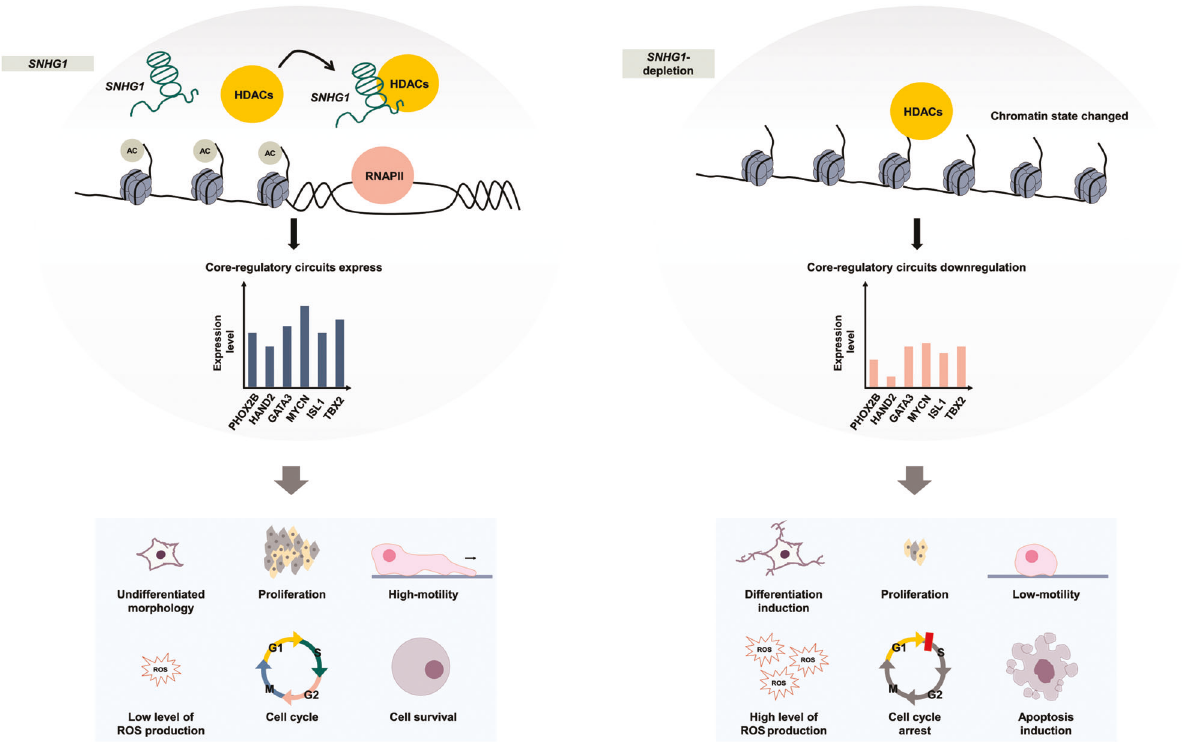
Fig. 6 Proposed mechanism of SNHG1 mediation in MYCN -ampli fi ed neuroblastoma cells. First, we examined how SNHG1 interacted with HDAC complexes, which regulate chromatin remodeling and cancer progression. Second, we validated relationships between core regulatory circuit (CRC) genes and SNHG1 . Together, CRC genes and SNHG1 maintained a ADRN cell state subtype in SK-N-BE(2)C neuroblastoma cells. The depletion of those regulators lead to several biological function changes, such as cell proliferation inhibition, cell cycle arrest, a decrease in cell migration ability, induction of cell differentiation, ROS production accumulation, and an increase in